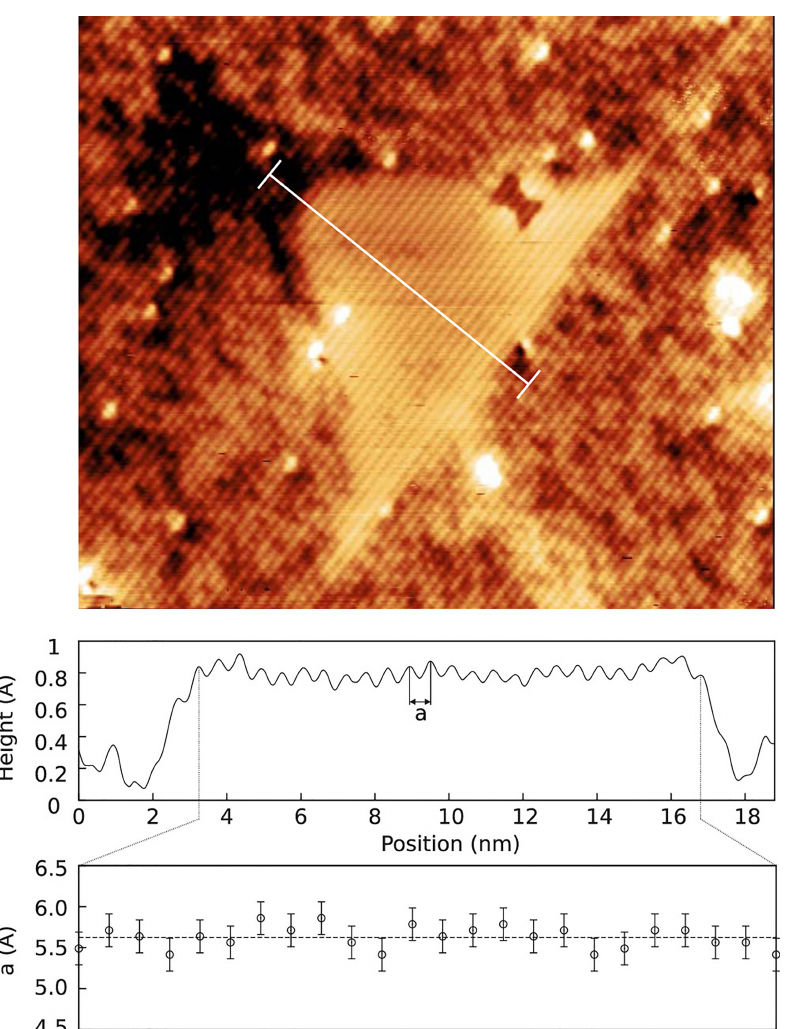
Figure 5. 40 × 34 nm 2 topographic image of a typical GaAs/AlGaAs QD ( top ) taken at bias voltage V b = –3 V and I t = 40 pA; An average cross-sectional profile ( top graph ) and separation between bilayers ( bottom graph ) along the line in the top figure. Reprinted from Ref. [73], © 2010 with the permission of AIP Publishing